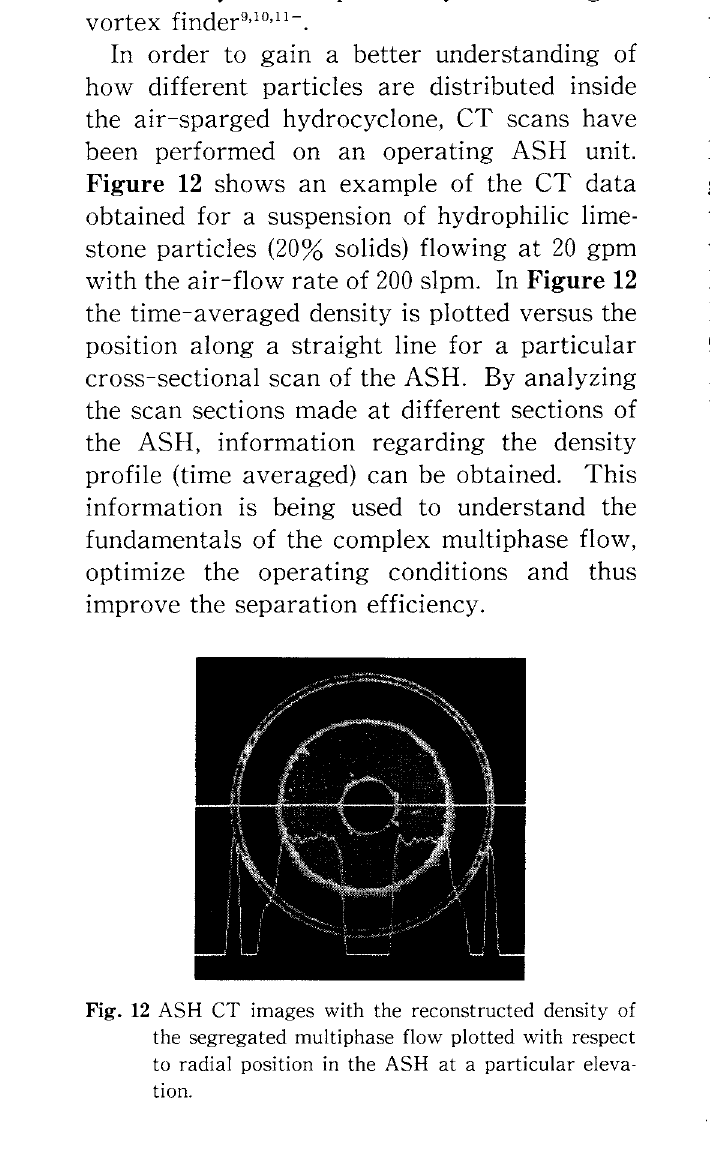
Fig. 12 ASH CT images with the reconstructed density of the segregated multiphase flow plotted with respect to radial position in the ASH at a particular eleva